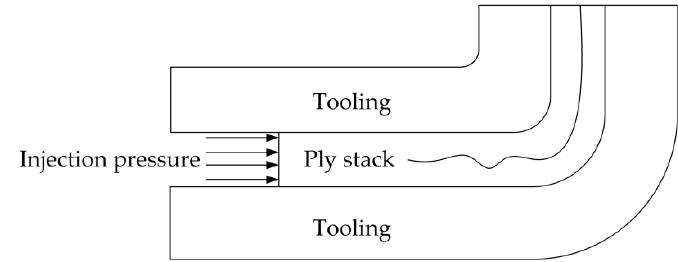
Figure 24. Schematic illustration of fiber washing e ff ect.